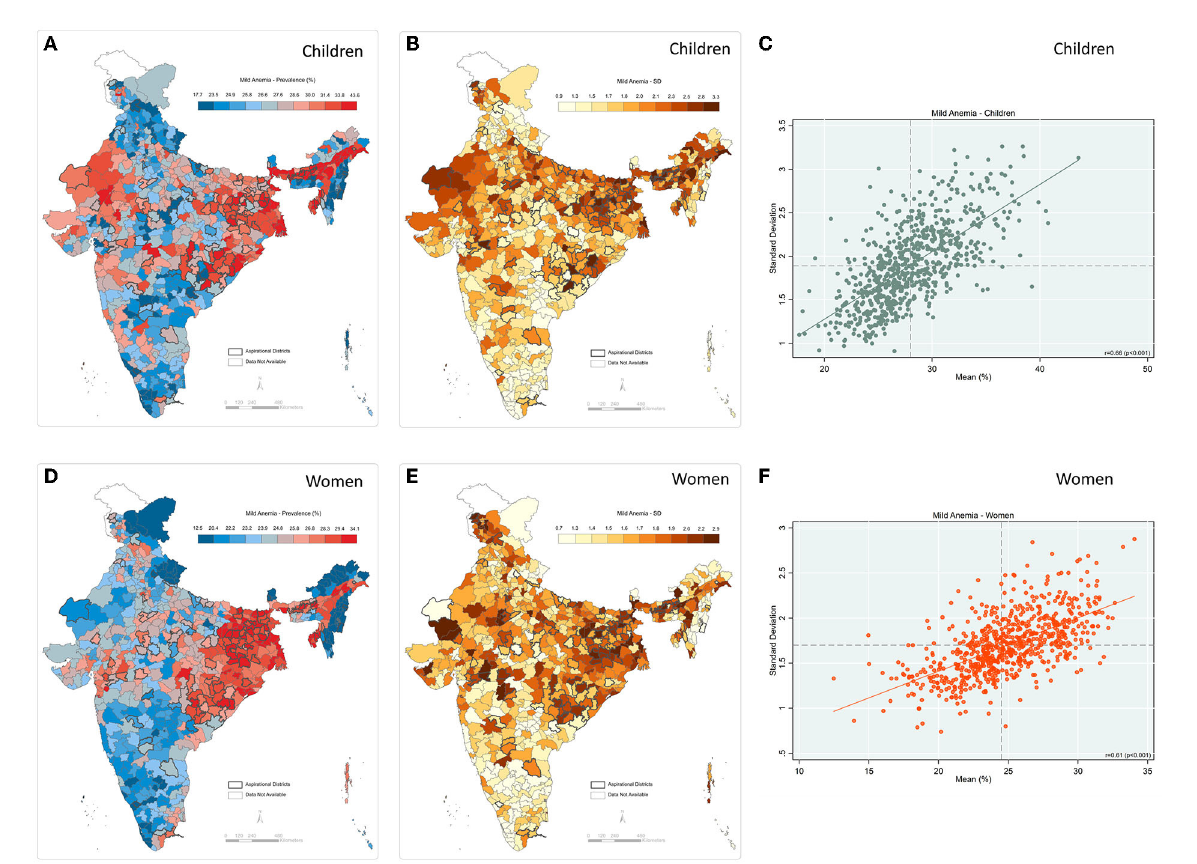
FIGURE7 Mild anemia (A) Map-district-level prevalence for children; (B) Map-inter-cluster SD for children; (C) Scatter-prevalence vs. SD for children; (D) Map-district-level prevalence for women; (E) Map-inter-cluster SD for women; (F) Scatter-prevalence vs. SD for women, India, NFHS